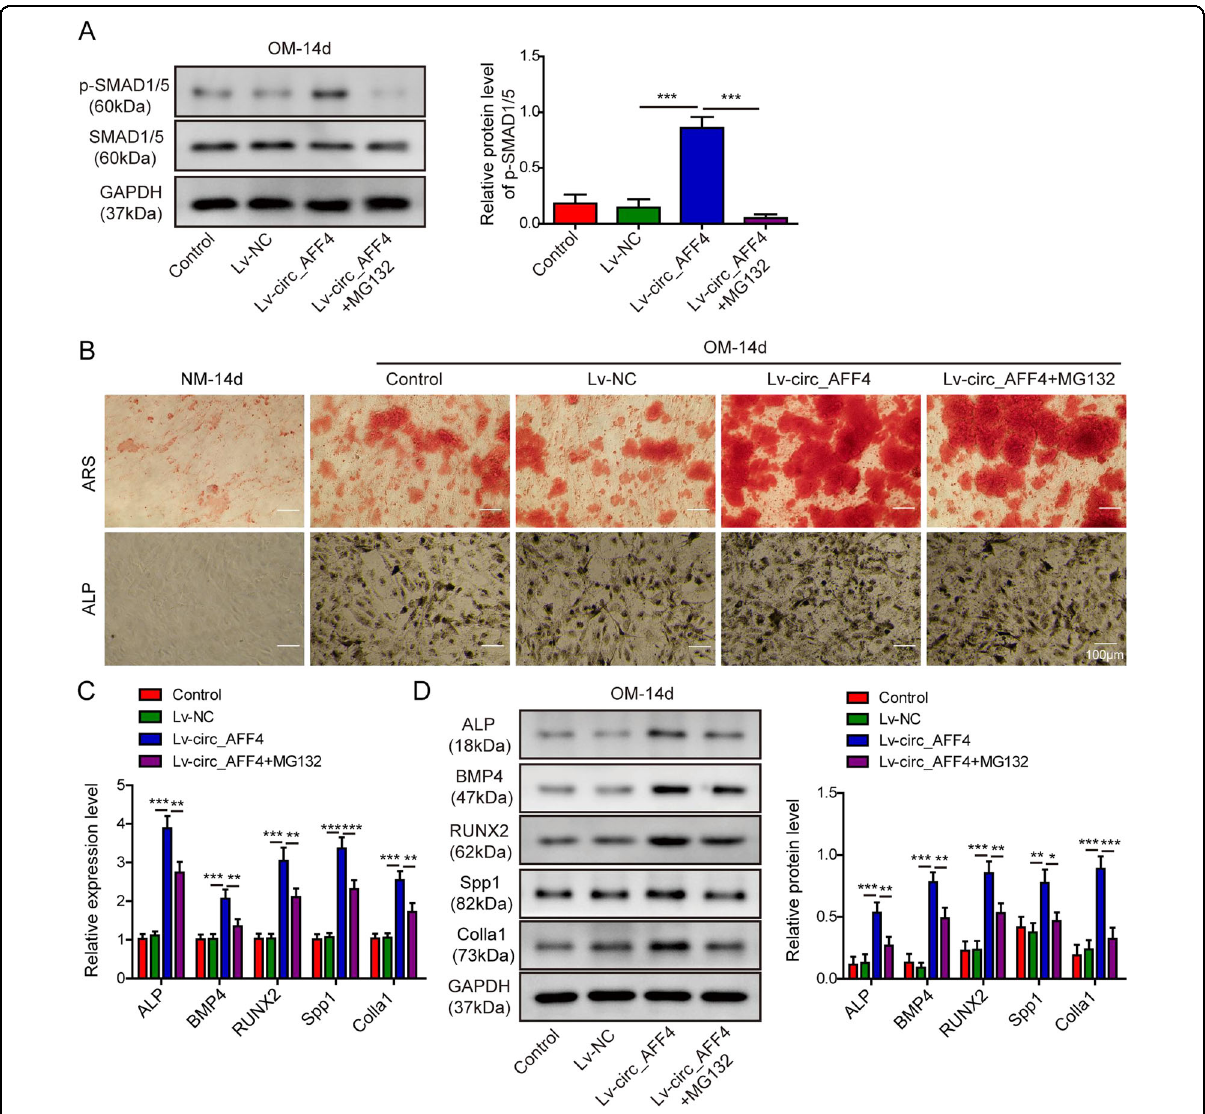
Fig. 7 Promotion of circ_AFF4 on osteogenic differentiation in BM-MSCs is associated with the SMAD1/5 pathway. BM-MSCs were transfected with lentiviruses encoding circ_AFF4 alone or co-treated with MG132 and further cultured in OM for another 14 days. A Expression of SMAD1/5 and phosphorylated SMAD1/5 was detected by WB analysis. B Osteogenic differentiation in BM-MSCs was evaluated by ARS and ALP staining assays. Expression of osteogenic marker genes ALP, BMP4, RUNX2, Spp1, and Colla1 in BM-MSCs was determined by qRT-PCR ( C ) and western blot ( D ). The data were shown as mean ± SD based on at least three independent experiments. * P < 0.05, ** P < 0.01, and *** P <